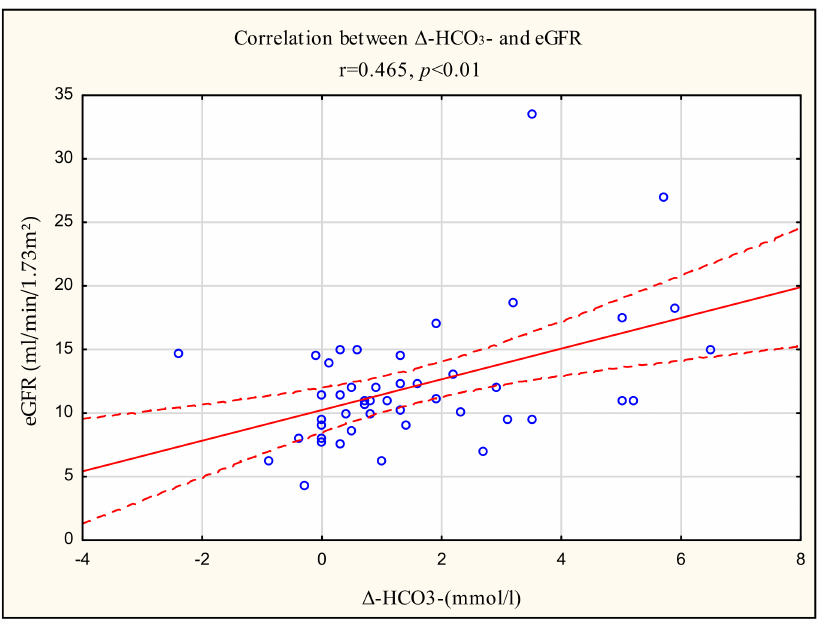
Figure 1. Pearson correlation between ∆ -HCO 3 − and eGFR in 49 CKD patients. 3.4. Receiver Operating Characteristic (ROC) Curves for the Variables with Most Important Discriminative Power for Group B of Patients (eGFR < 10 mL/min/1.73 m 2 ) Six ROC curves were generated for the parameters that best correlated with the eGFR. On this basis, it was found that the highest discriminative power for GFR < 10 mL/min/1.73 m 2 is − with area under curve (AUC) 0.716. The cut point was determined at 0.5 mmol/L ∆ -HCO 3 (Figure 2). For this point, the sensitivity, specificity equals 67% and 75%, respectively.